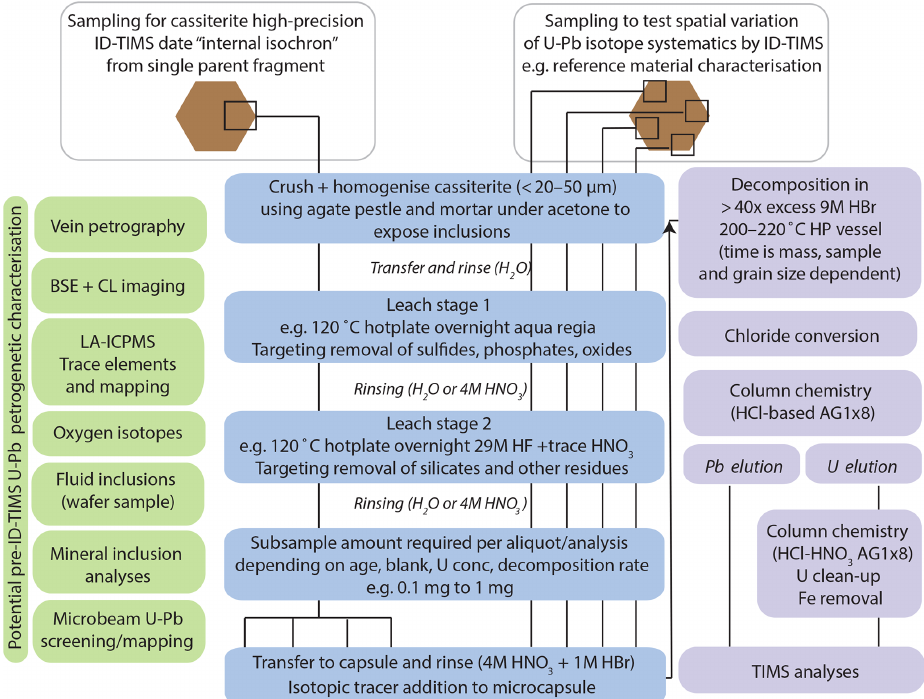
Figure 3. A generalised workflow for cassiterite ID-TIMS U–Pb geochronology. ID-TIMS analyses can be employed after the listed pet- rogenetic characterisation techniques on sample material. The schematic representation of sample aliquots and sub-aliquots illustrates the different approaches utilised within the study based on application (characterising heterogeneity in reference materials or internal isochron approach to avoid issues with spatial heterogeneity in Pbc composition; see Fig. 7 for further details on internal isochron formed from sub- aliquots). Note that many experimental variables will be sample material and user requirement dependent. For a discussion of decomposition times, see Sect.